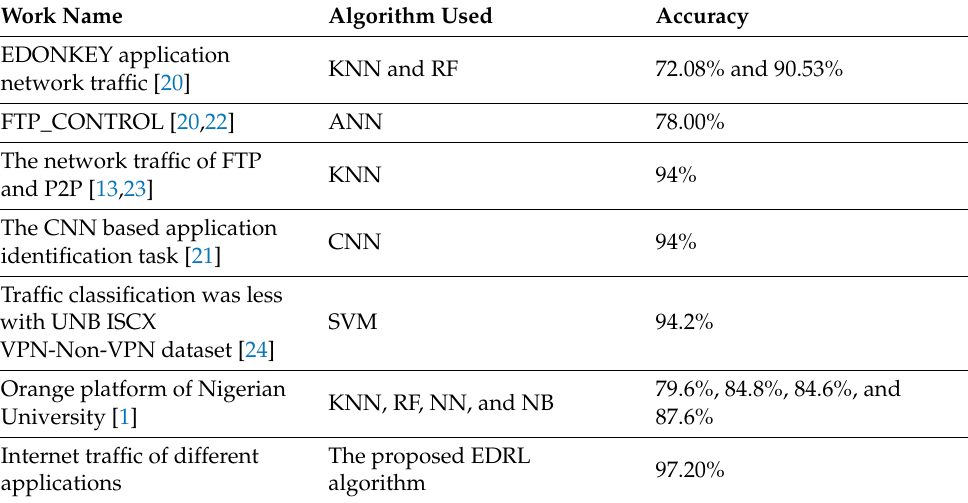
Table 13. Various ML and DL accuracy measure comparisons with the proposed EDRL